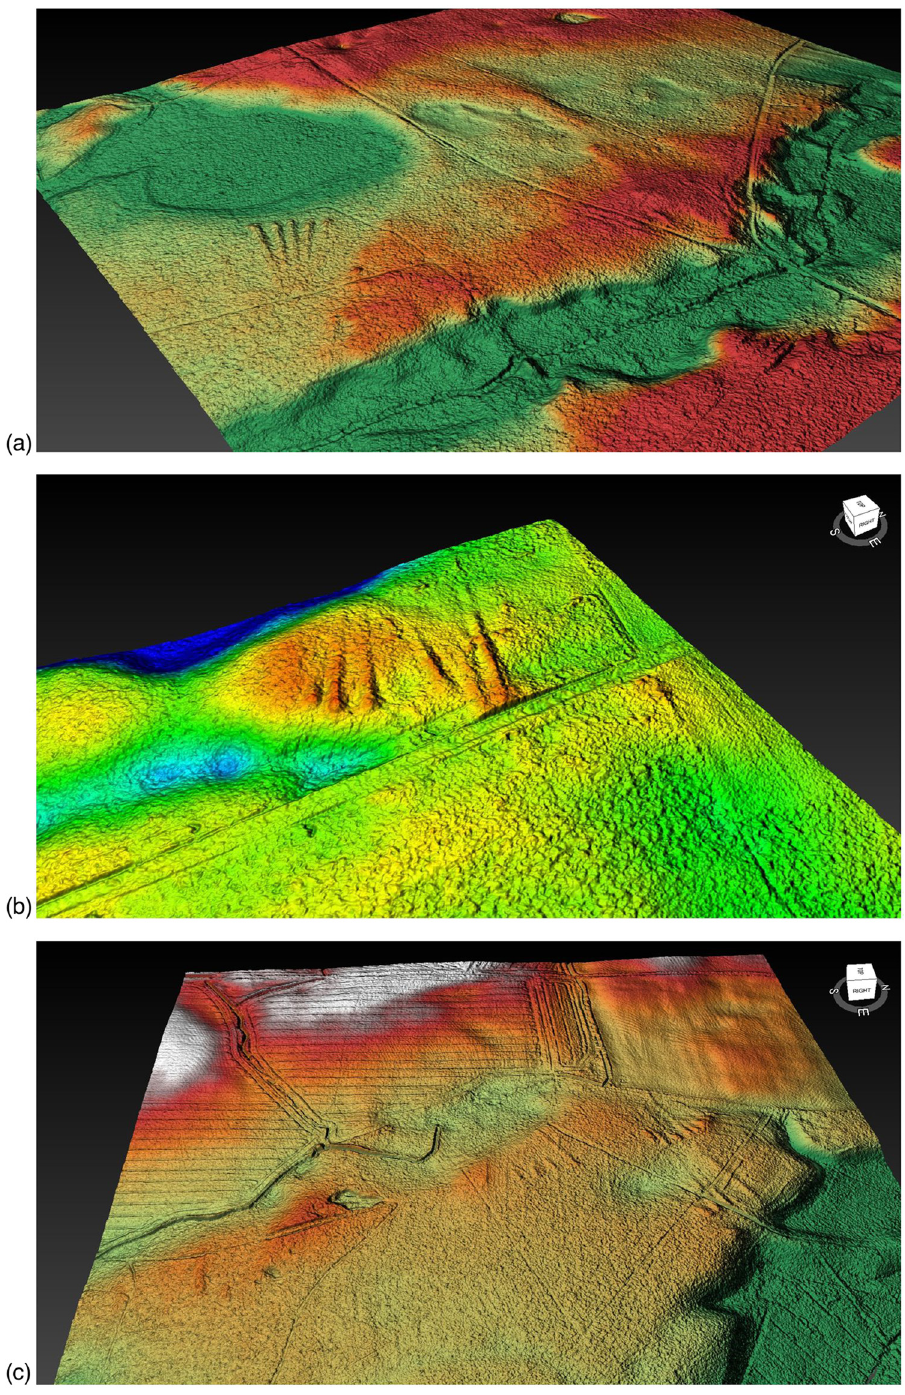
Figure 2: Examples of megalithic cemeteries from the Middle Warta catchment. ( a ) Sobota district Pozna ń ; ( b ) Ka ź mierz district Szamotu ł y; ( c ) S ł opanowo district Szamotu ł y. See Figure 1 for site locations. Visualization was made by T.